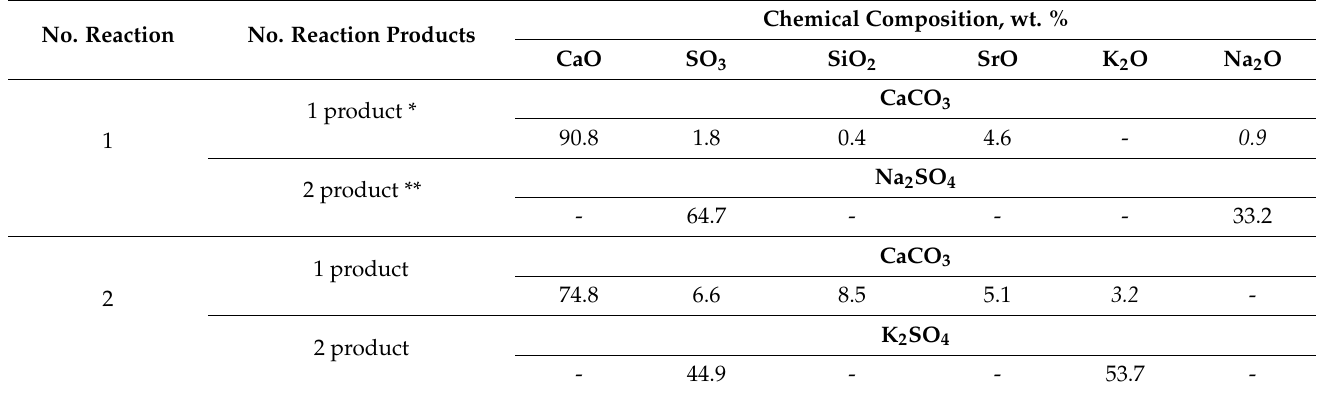
Table 5. Chemical composition of the leaching reaction products of washed